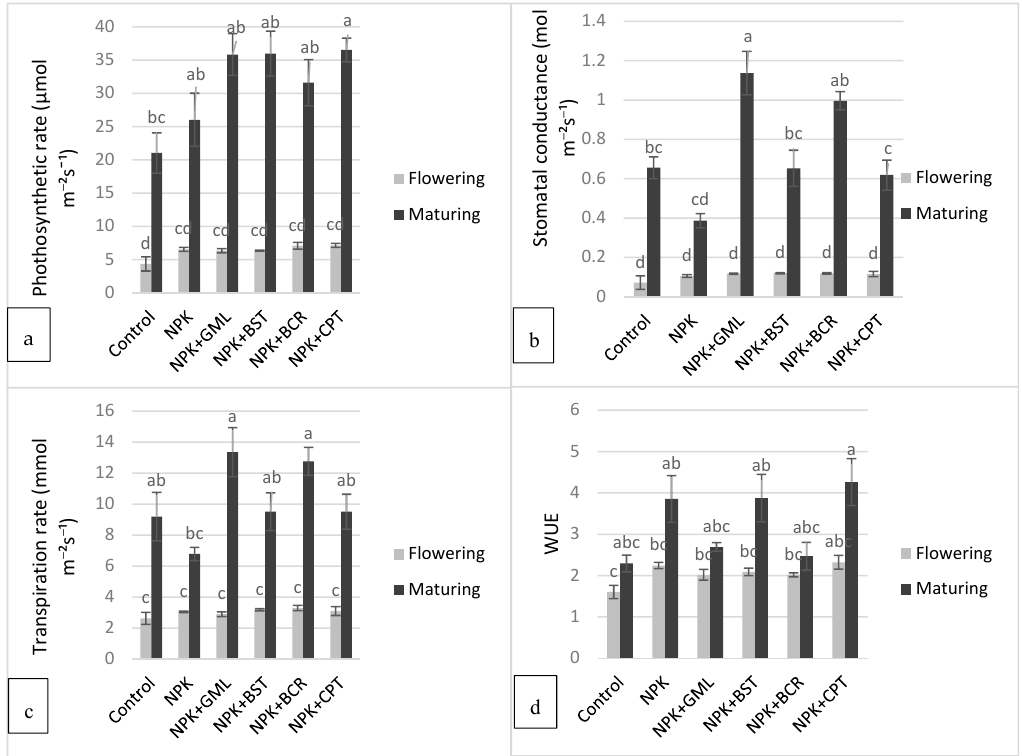
Figure 2. Figure indicates the ( a ) photosynthetic rate, ( b ) stomatal conductance, ( c ) transpiration rate, and ( d ) water use efficiency (WUE) at both the flowering and maturing stages of rice. Each data item represents the mean of replicates and the vertical bar represents the standard error of the mean ( n = 3). Different letters indicate a significant difference ( p < 0.05). NPK = NPK fertilizer, GML = ground magnesium limestone, BST = basalt, BCR = biochar, CPT = compost.